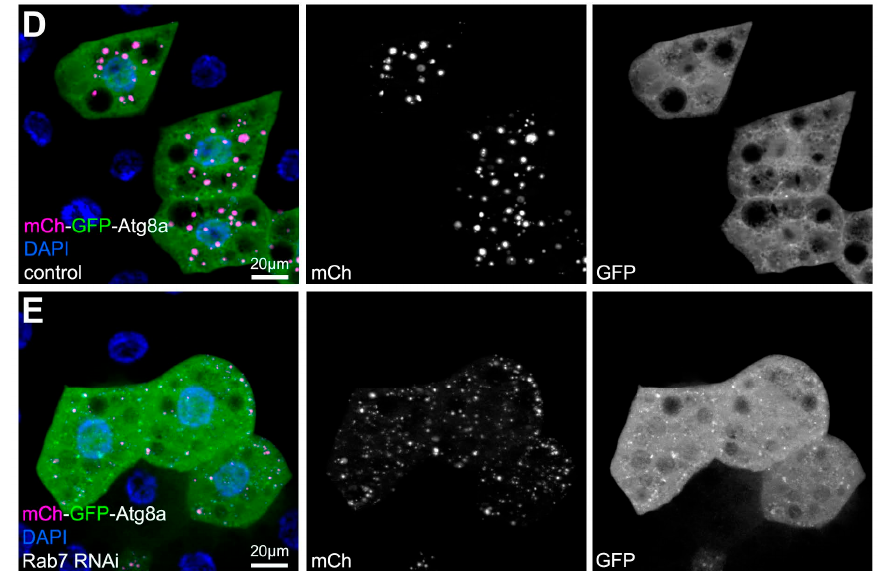
Figure 1. ( A – C ) Starved larval fat tissue samples from mosaic animals expressing RNAi constructs only in Green Fluorescent Protein (GFP)-positive cells. ( A ) GFP-marked Atg1 RNAi cells fail to